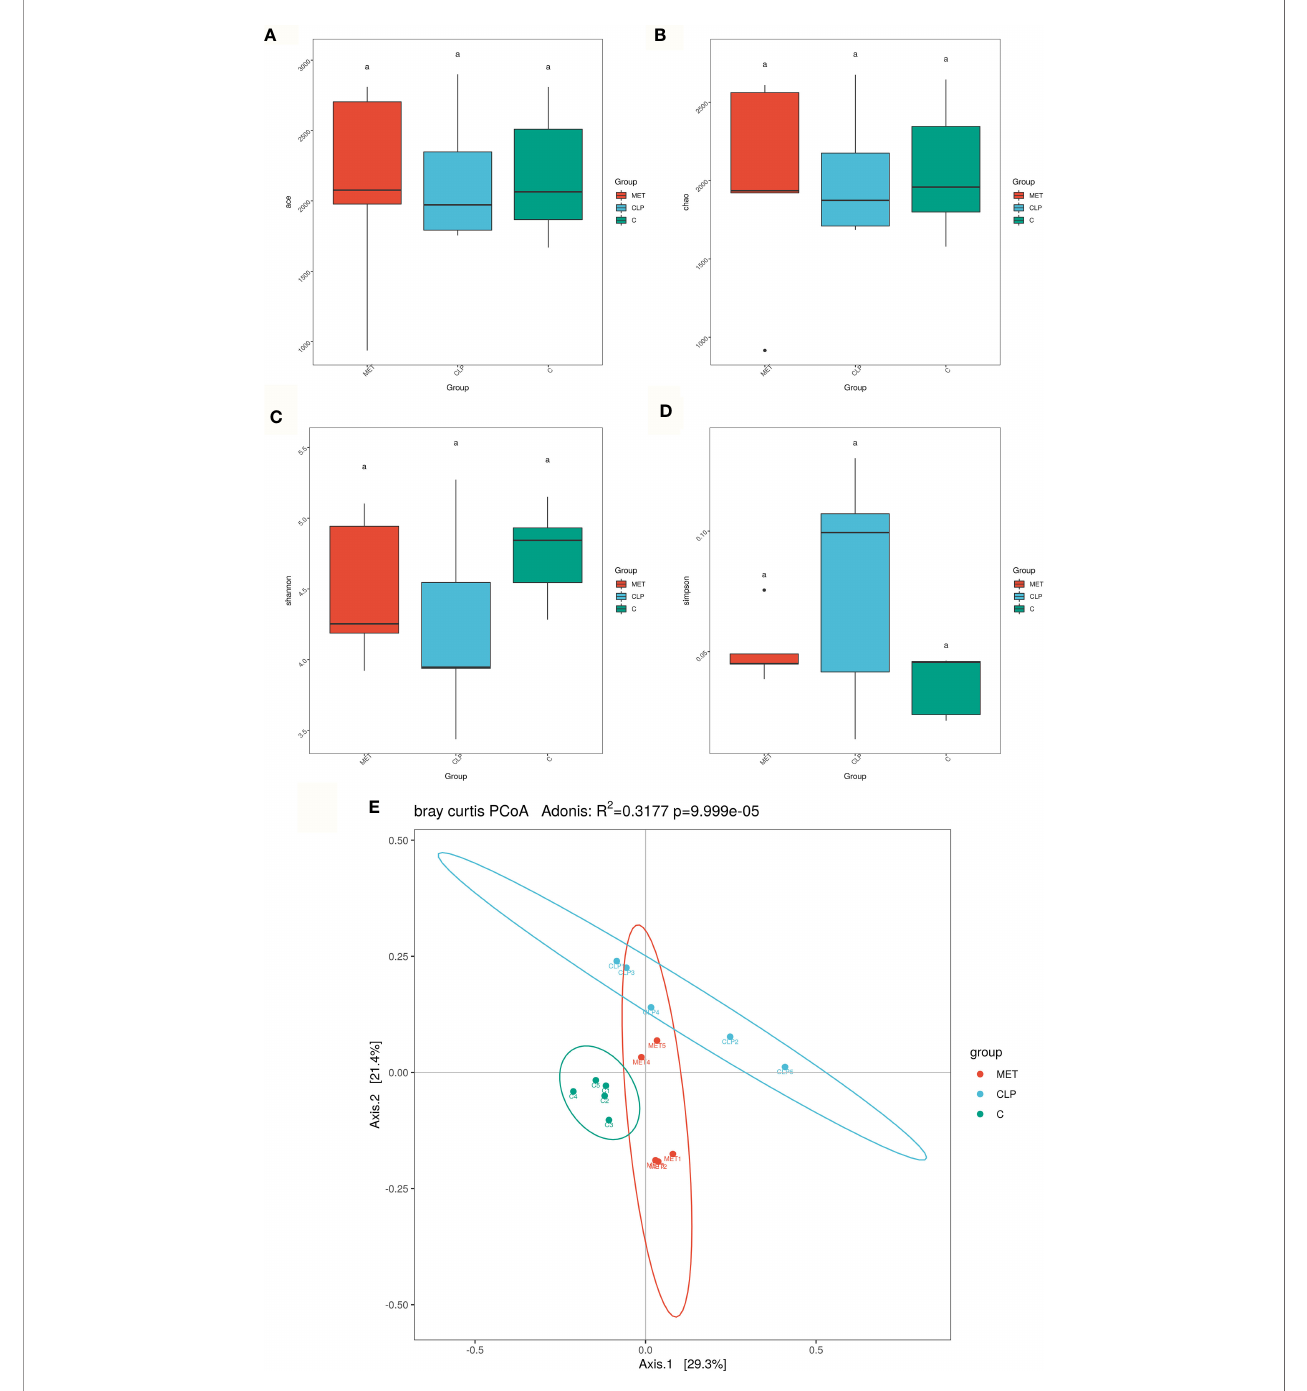
FIGURE 2 | Effect of metformin on gut microbiota in septic rats. (A – D) 16S rRNA analysis showed that the alpha diversity of gut microbiota such as Ace, Chao1, Shannon and Simpson index was slightly reduced in the CLP group compared to the C group. However, metformin treatment slightly reversed the alpha diversity reduction caused by sepsis. (E) The beta diversity of gut microbiota showed that the compositions in the CLP group were different from the C group. However, the composition of the gut microbiota in the MET group was similar to the C group. a P<0.05 ( n =